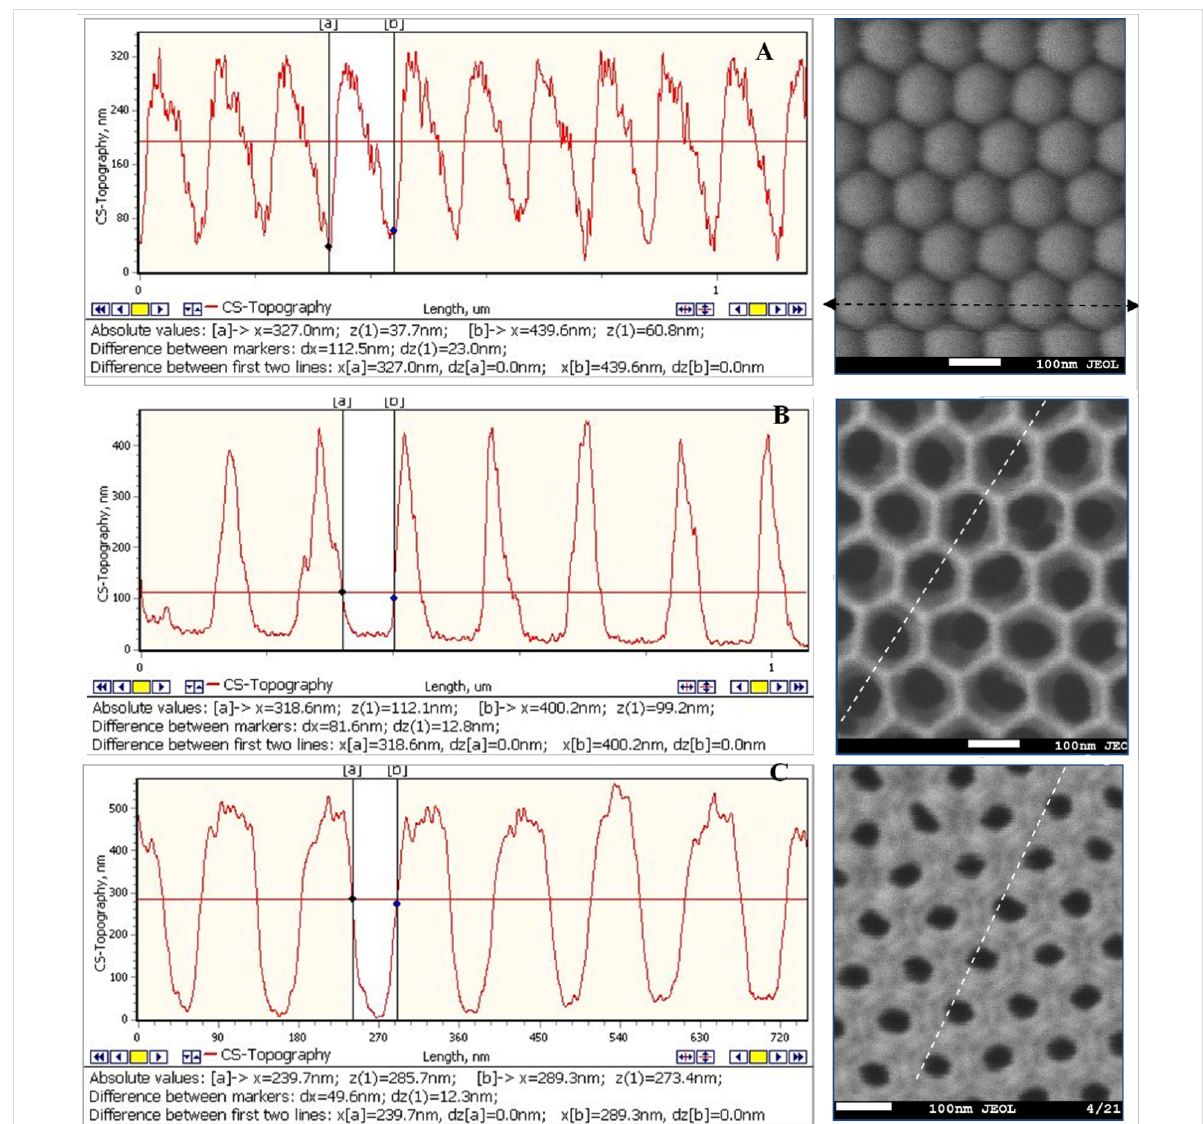
Figure 7: SEM images and AFM profiles of the back surface before (A) and after (C) etching of the barrier layer and the front surface (B) after etching of the barrier layer.